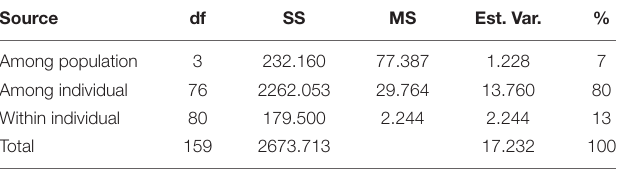
TABLE 7 | Analysis of molecular